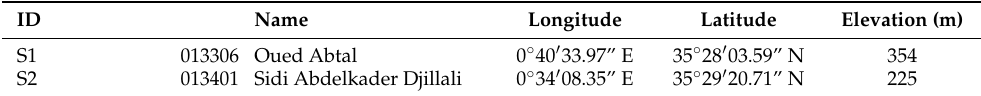
Figure 1. Study area, as well as pluviometric and hydrometric network. Table 1. Basic characteristics of rainfall